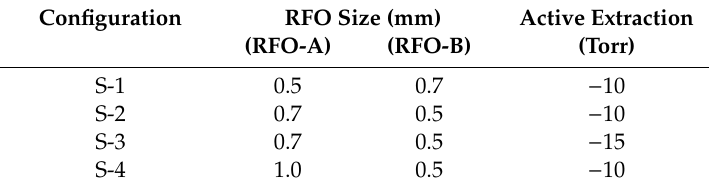
Table 1. Parametric variables for static mode (locations of RFO-A and RFO-B are shown in Figure 1).